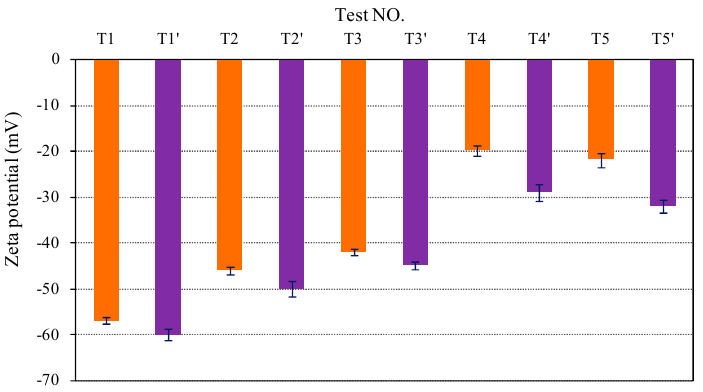
Figure 2. Colloidal silica zeta potential under different conditions.